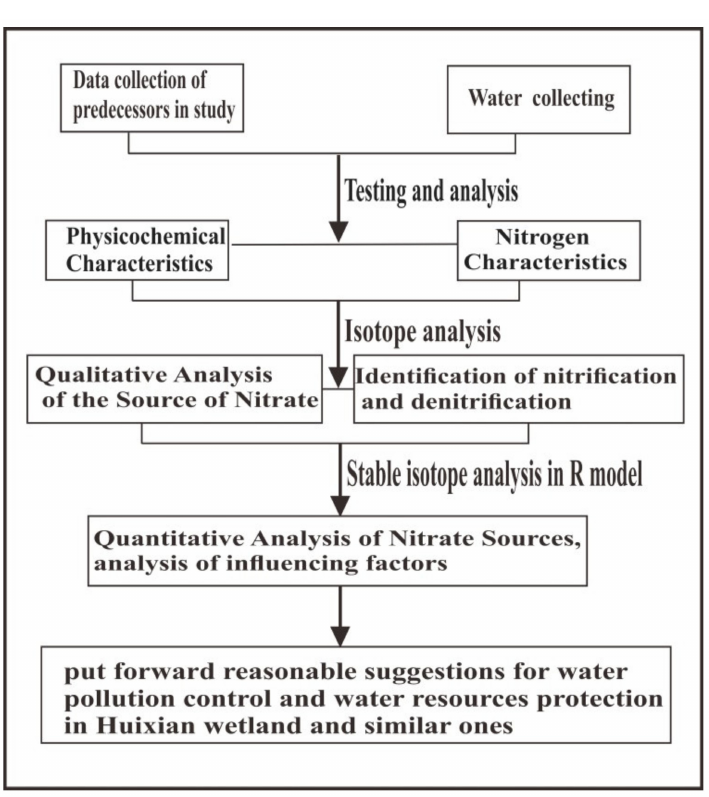
Figure 2. The flow chart illustrating the steps of the methodology in the